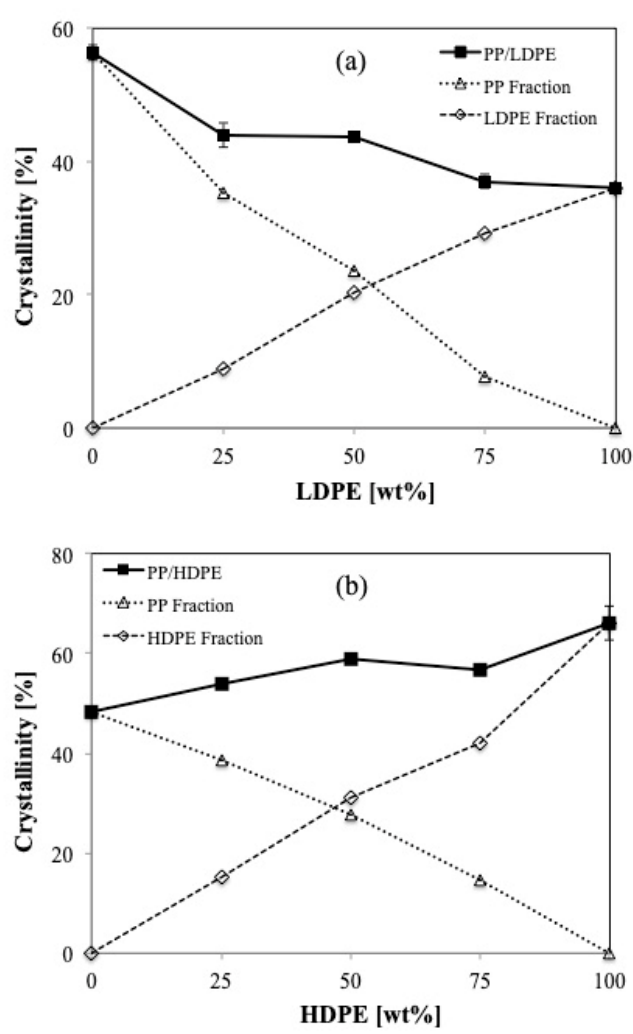
Figure 3. % Crystallinity of ( a ) PP/LDPE blends and ( b ) PP/HDPE blends at different blend compositions.